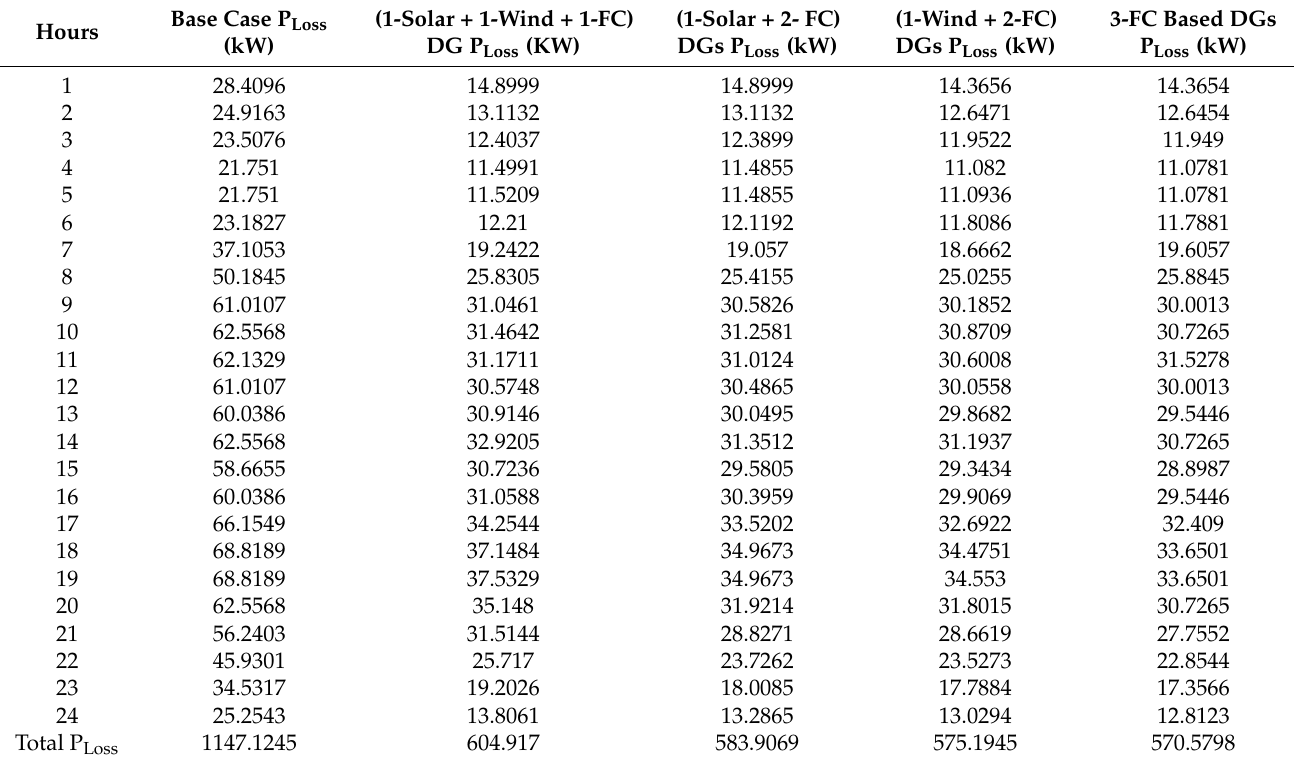
Table 7. RDGs P Loss comparison for a typical day with different